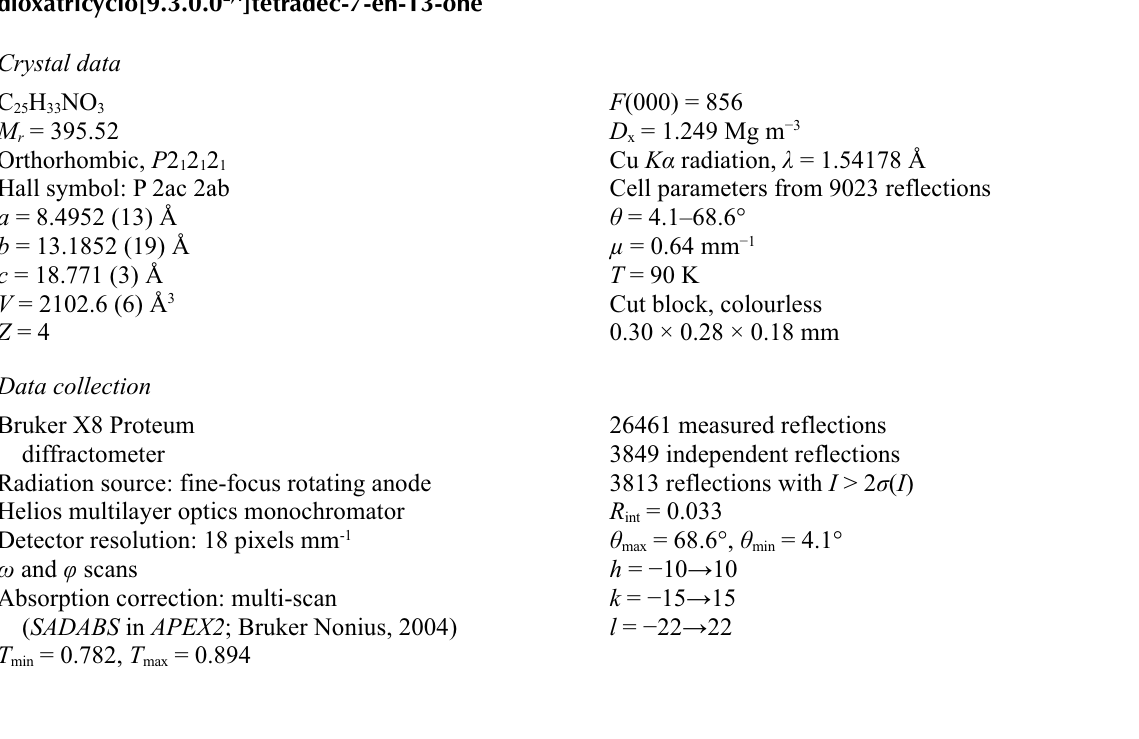
A packing diagram, viewed down the a axis, hydrogen atoms have been omitted for clarity. (12 R )-4,8-dimethyl-12-[(1 ′ R )-1 ′ ,2 ′ ,3 ′ ,4 ′ -tetrahydro-1 ′ -naphthyl)aminomethyl]-